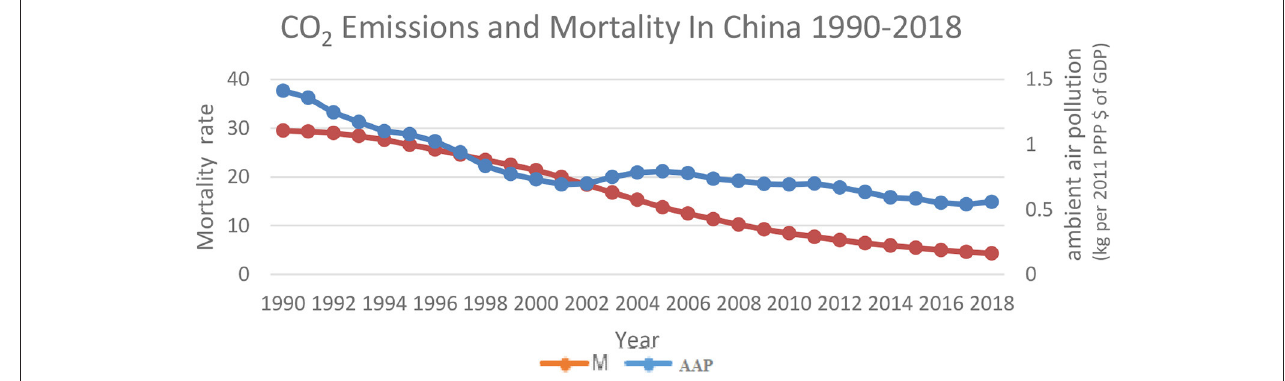
FIGURE 2 | Ambient air pollution and mortality.